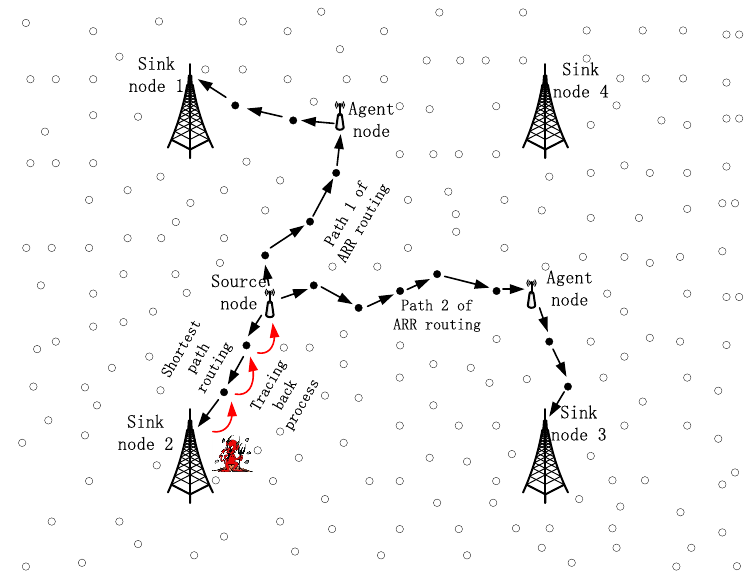
Figure 2. Shortest path routing and ARR routing.